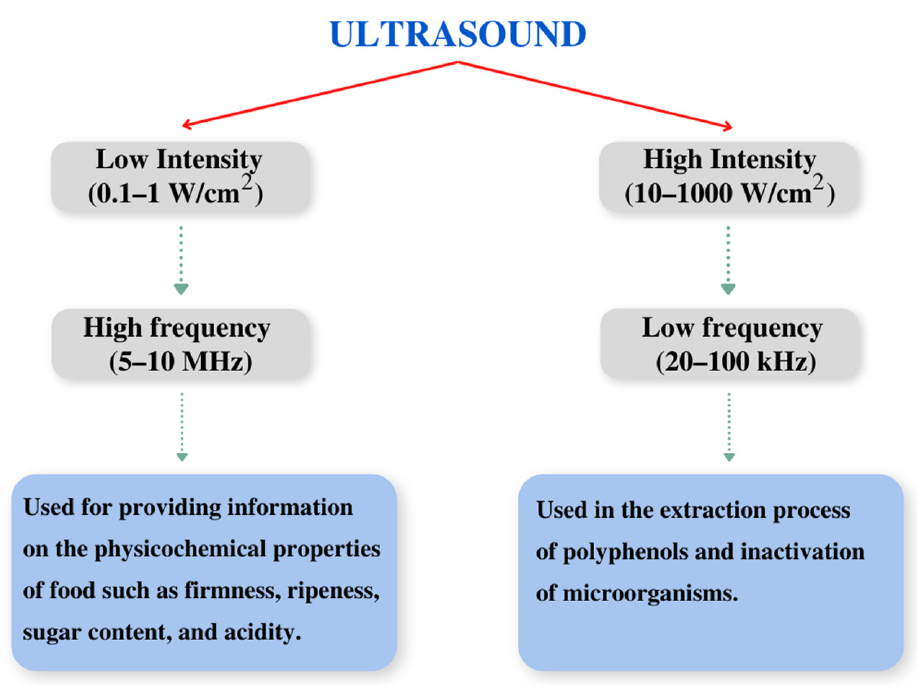
Figure 3. Simplified schematic of ultrasound assisted extraction of polyphenols.